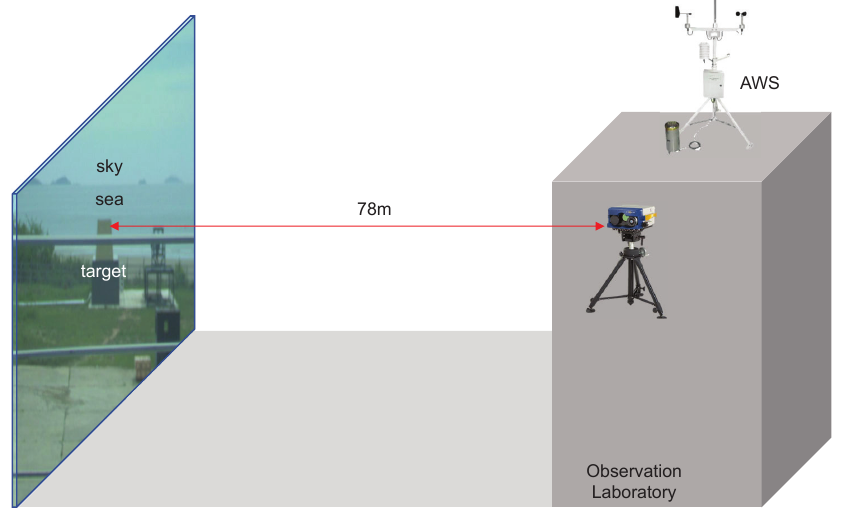
Figure 1. Measurement scenario in an outdoor environment: FTIR is located in an air conditioned room and AWS is installed on the roof. The background scene is 78 m away from the